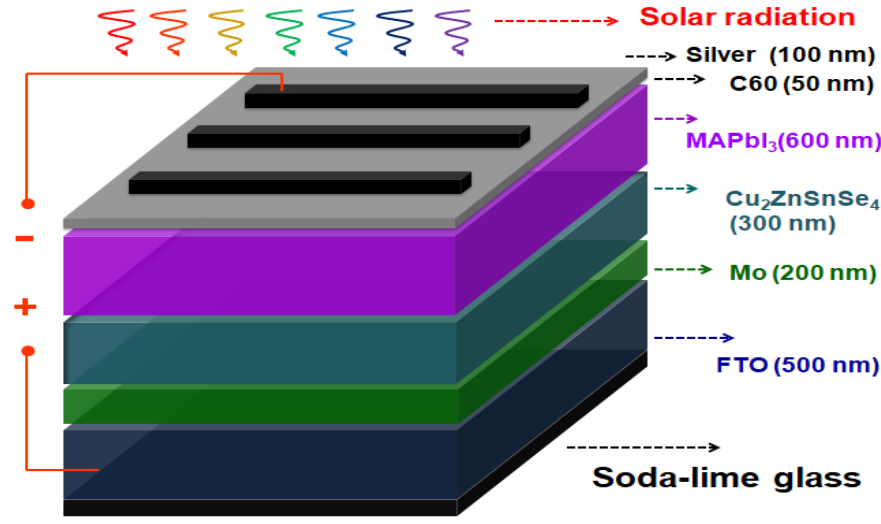
Figure 9. Schematic illustration of the multilayered structure of Ag/C 60 /MAPbI 3 /Cu 2 ZnSnSe 4 /Mo/FTO thin-film solar cell.